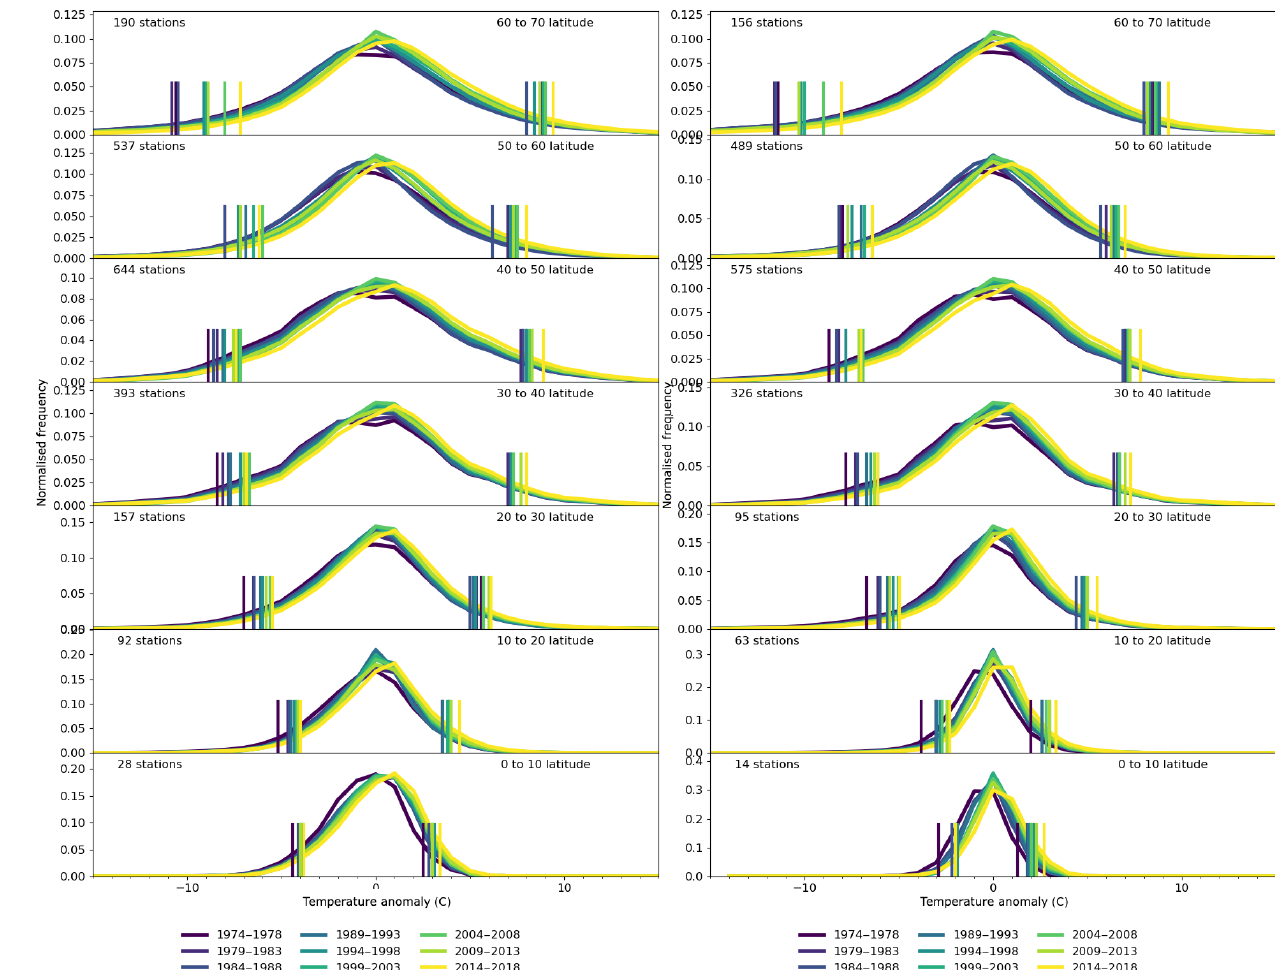
Figure 2. Dry-bulb temperature distributions in latitudinal bands for daytime (left) and night-time (right) observations for the Northern Hemisphere stations. The y axis has been normalised for ease of comparison. The number of stations contributing to each set of distributions is shown in the top left of each sub-panel, with the latitude range in the top right. The short vertical bars indicate the location of the 5th and 95th percentile values for each